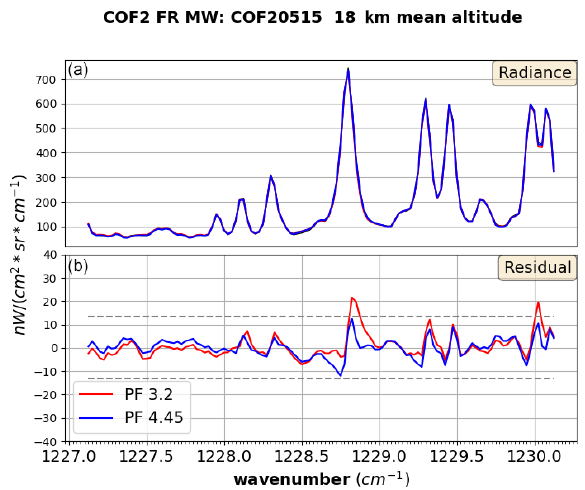
Figure 8. (a) Observed spectrum (black curve, under the blue one) and simulations at 18km with the old (red curve) and the new (blue curve) spectroscopic parameters for a microwindow used for COF 2 retrieval of FR measurements. (b) Residuals obtained with simula- tions generated with the old spectroscopic database (red curve) and the new one (blue curve), compared with the measurement noise (grey curves).